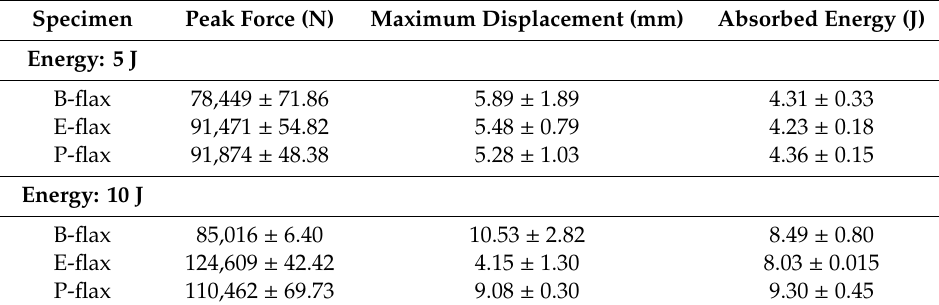
Figure 10. Force versus displacement curve of flax fibre composites using three resin system ( a ) 5 J, ( b ) 10 J. Table 5. Parameters obtained from impact test on di ff erent